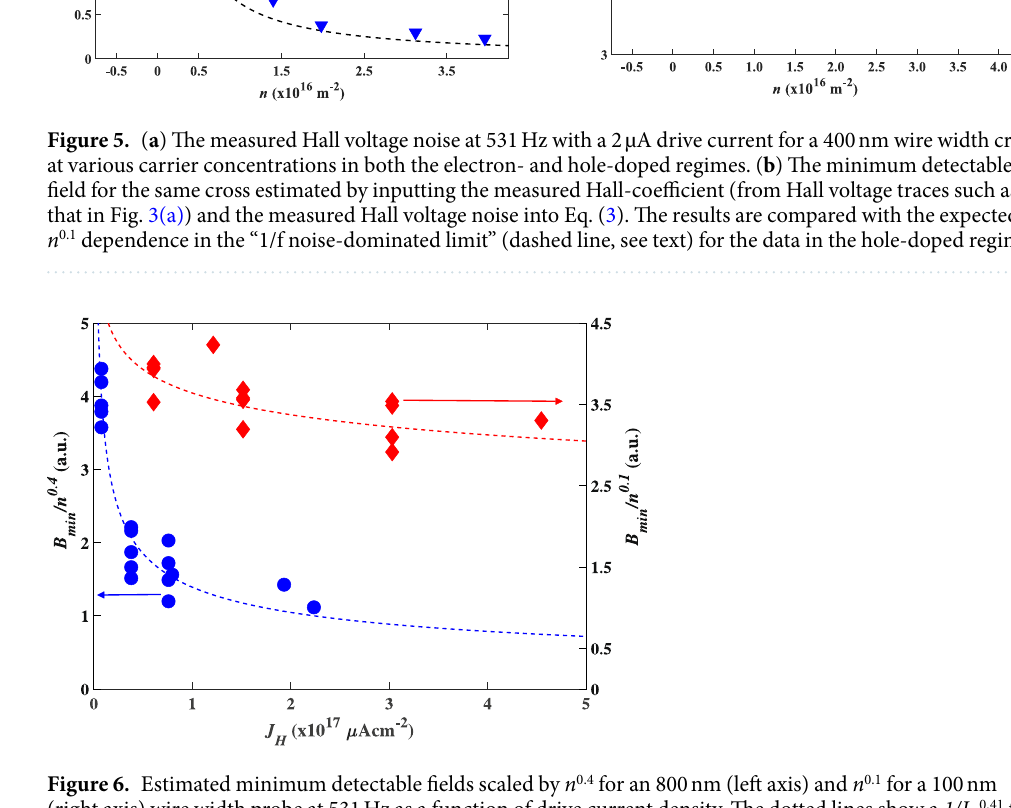
Figure 6. Estimated minimum detectable fields scaled by n 0.4 for an 800 nm (left axis) and n 0.1 for a 100 nm (right axis) wire width probe at 531 Hz as a function of drive current density. The dotted lines show a 1/J H 0.41 fit for the 800 nm probe and a 1/J H 0.11 fit for the 100 nm